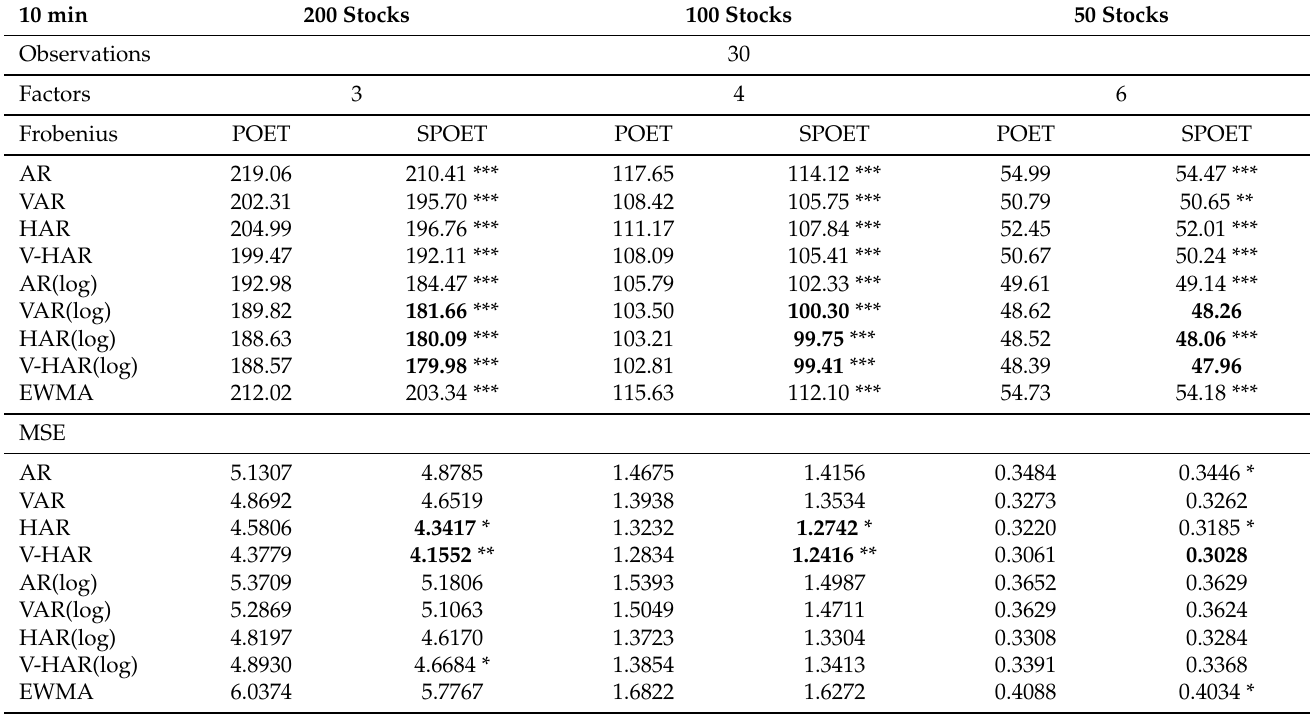
Table 3. Average forecasting losses for 10-min interval intraday